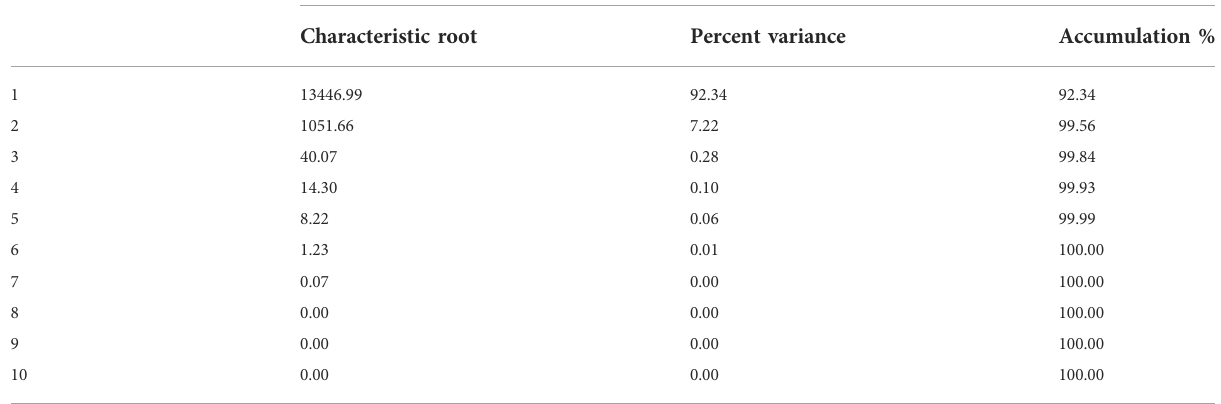
TABLE 3 Variance explanation rate table.